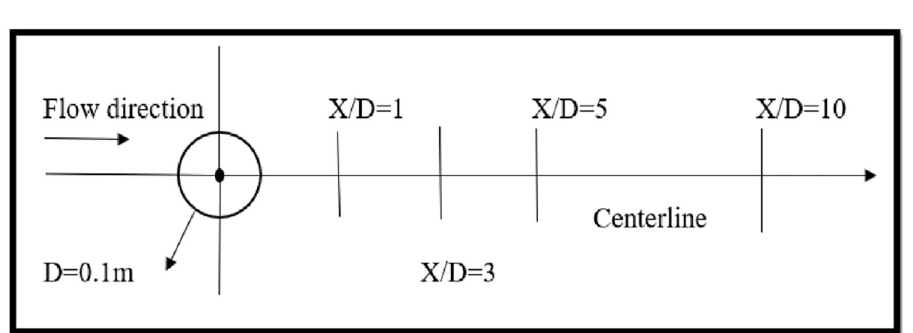
Fig 5. Vertical profiles and centerline sketch behind the cylinder.